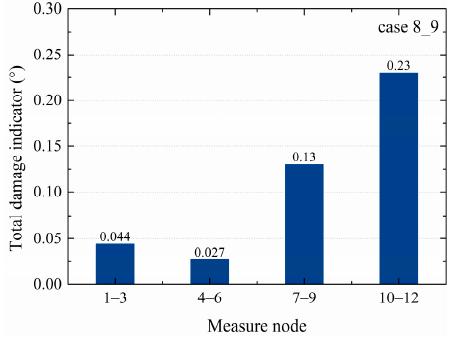
Figure 10. Total damage indicator of case 8_9 from the TVSR model.